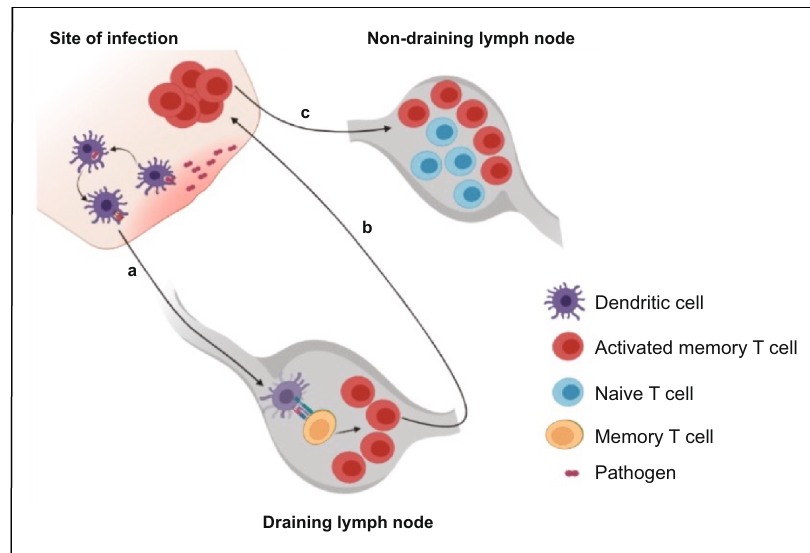
Fig. 7 Proposed model postulating the cross-talk between naïve and activated memory CD8 T cells. a Upon pathogen re-exposure memory CD8 T cells become activated in the draining lymph nodes and b migrate to the site of infection to control the pathogen. c A proportion of the activated memory CD8 T cells migrates to antigen-free lymph nodes where they interact with naïve CD8 T cells resulting in acquisition of an activated/memory phenotypic properties by naïve CD8 T cells. The fi gure was created by BioRender under University of Pittsburgh